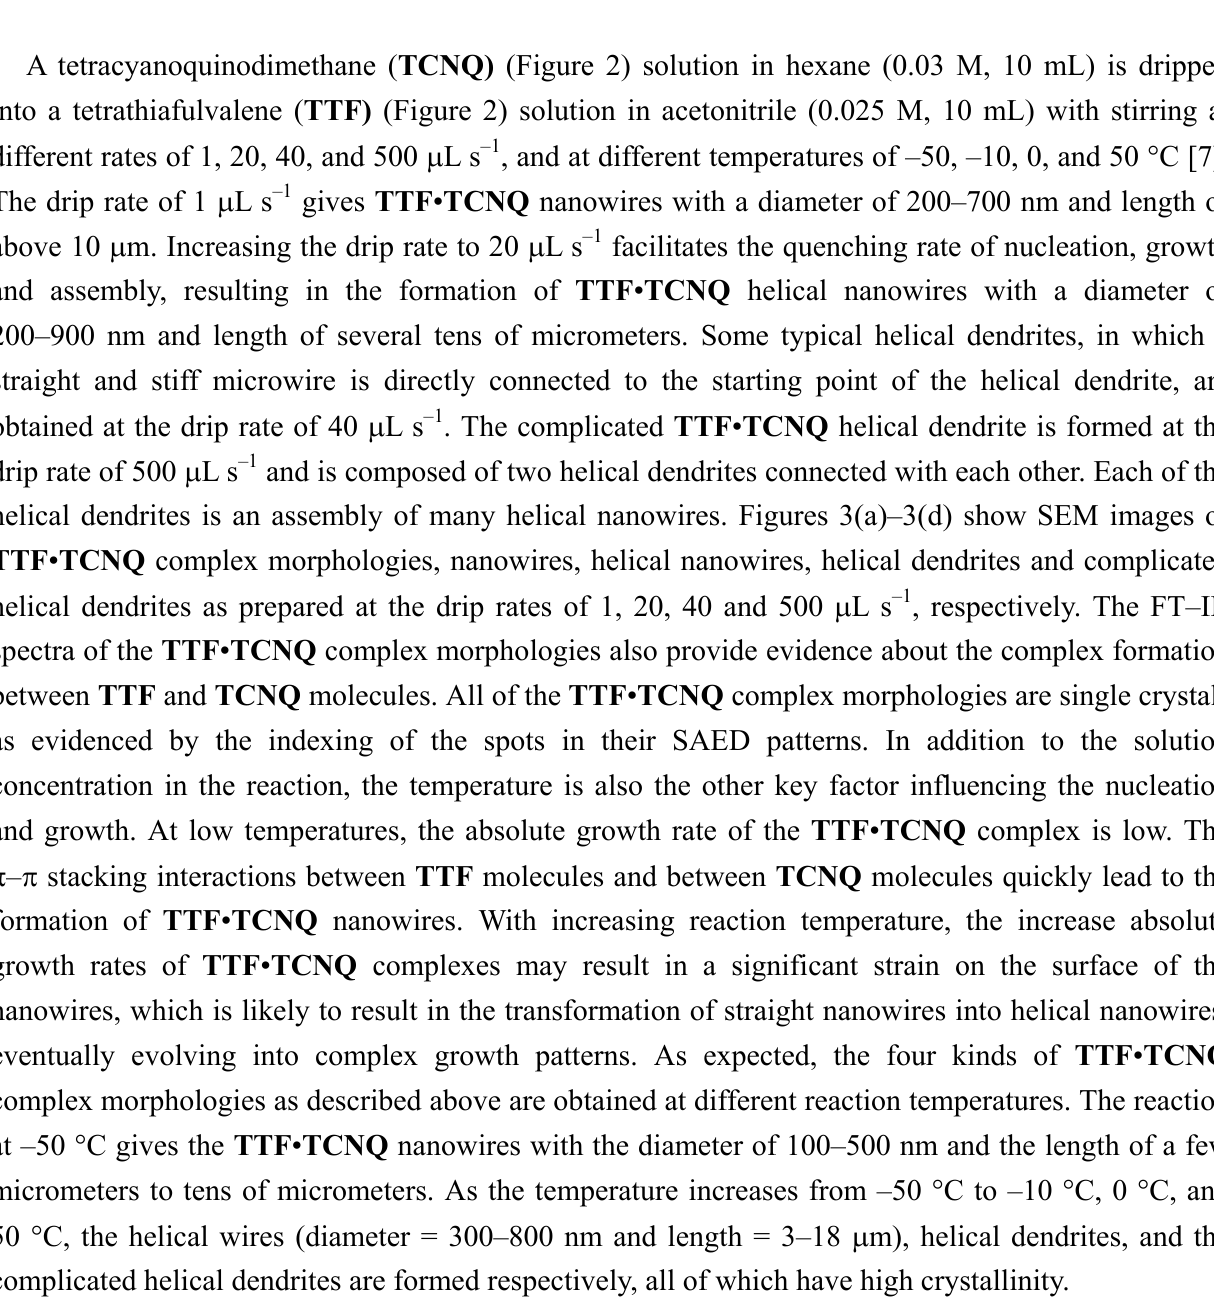
Figure 2. The chemical structures of tetrathiafulvalene ( TTF ) and tetracyanoquino- dimethane ( TCNQ